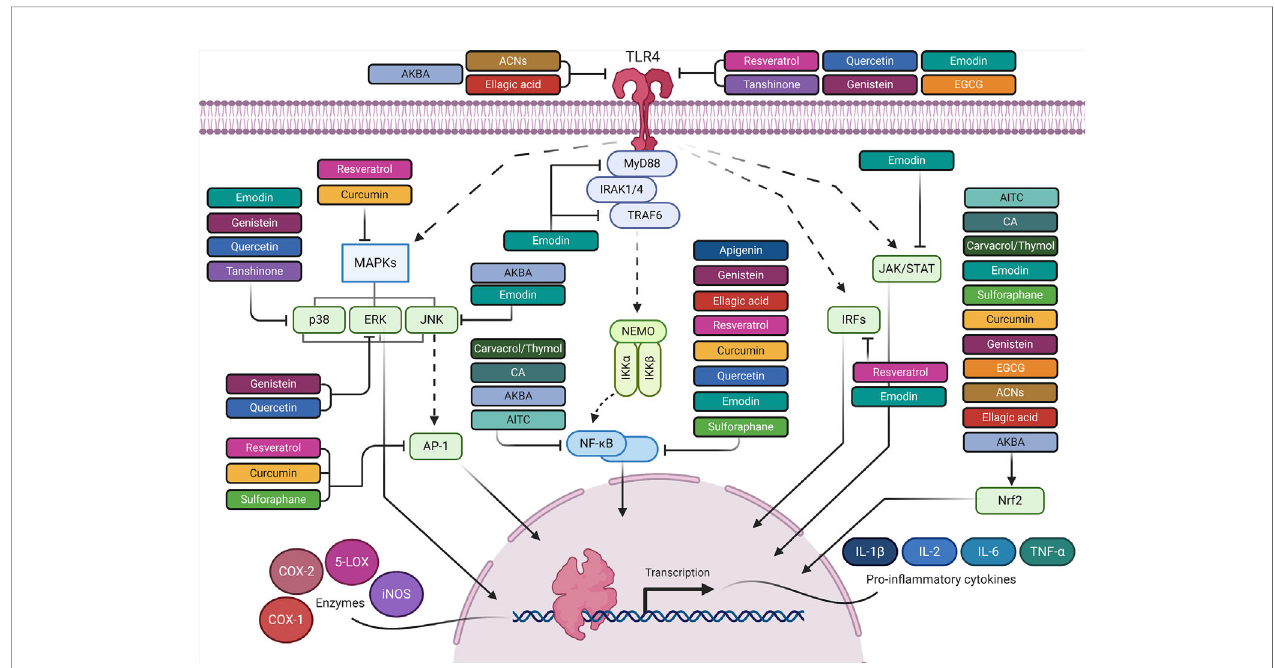
FIGURE 1 | The anti-in fl ammatory mediated effects of phytochemicals along the TLR4 signaling pathway. Created with